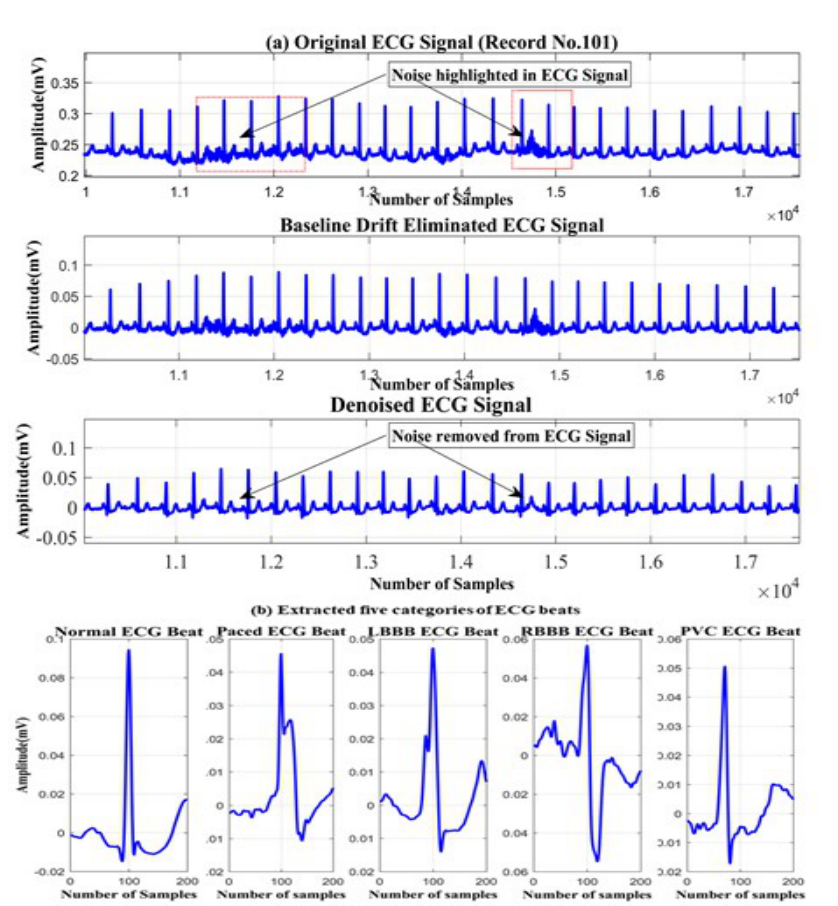
Figure 2 . (a) Pre-processed ECG signal (b) Extracted five categories of ECG beats single beat. This dataset (6000 * 130) is subjected